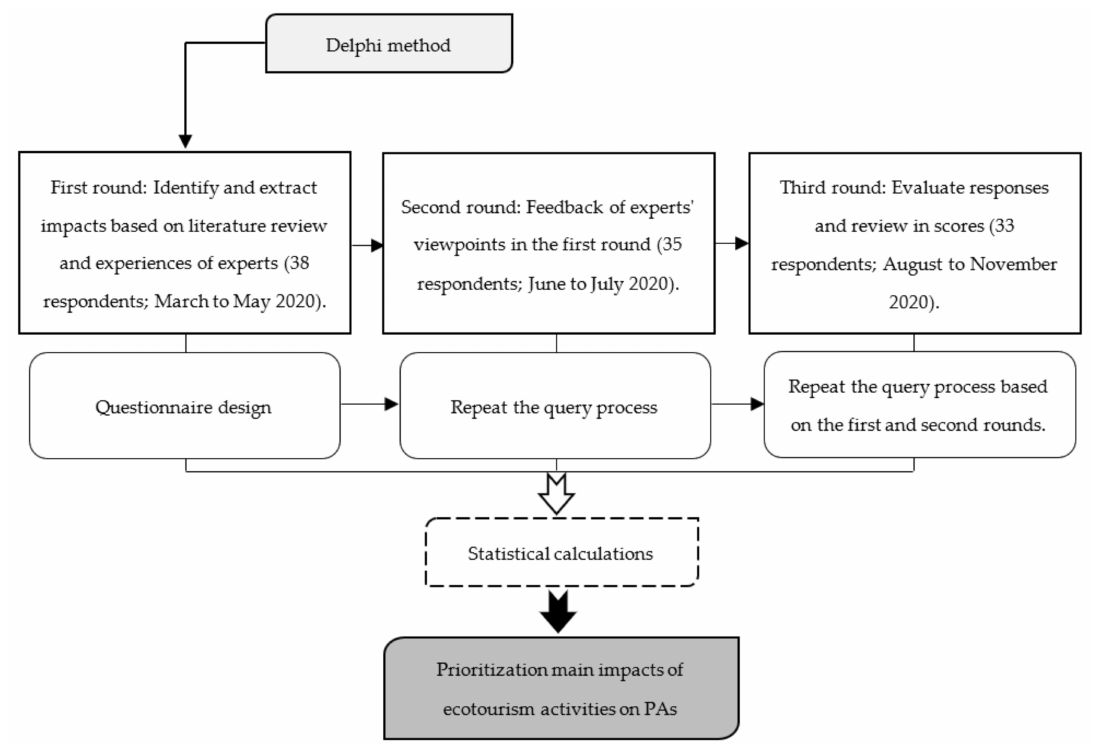
Figure 3. Main steps of the Delphi